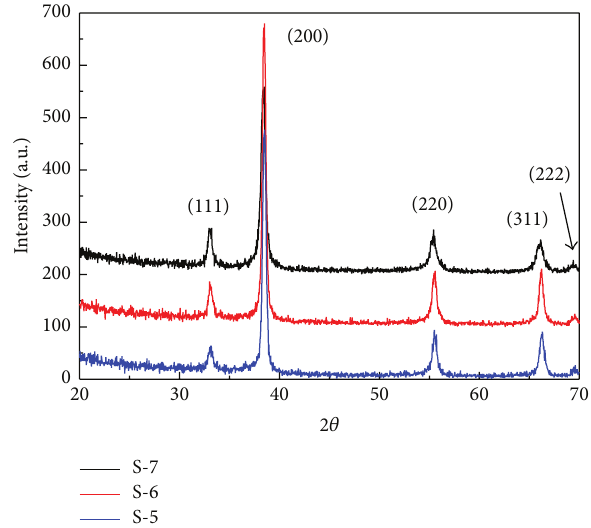
Figure 2: X-ray diffraction patterns of the Al-doped CdO films of S-5, S-6, and S-7